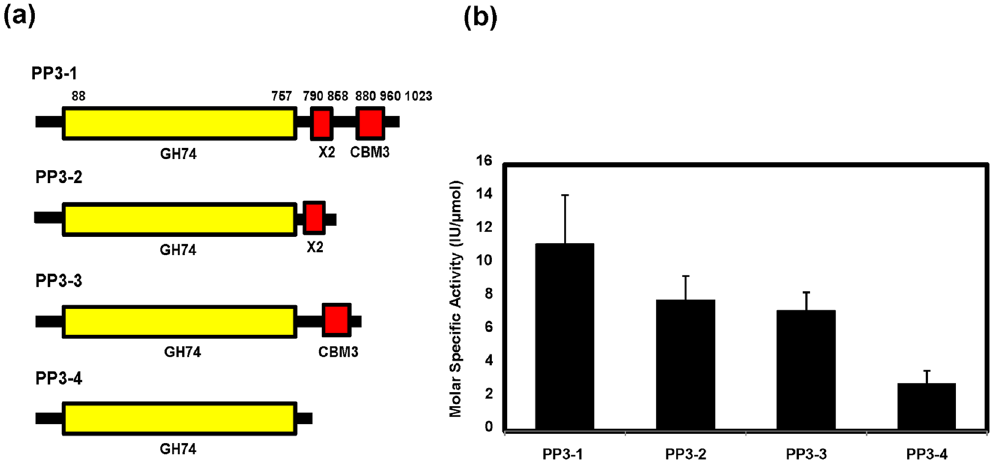
Figure 4. ( a ) Molecular organization of X2-CBM3 containing xyloglucanase and its truncated derivatives used in the study and ( b ) Specific activity of the derivatives against ammonia-treated biomass. Error bars represent the standard deviations of experiments performed in